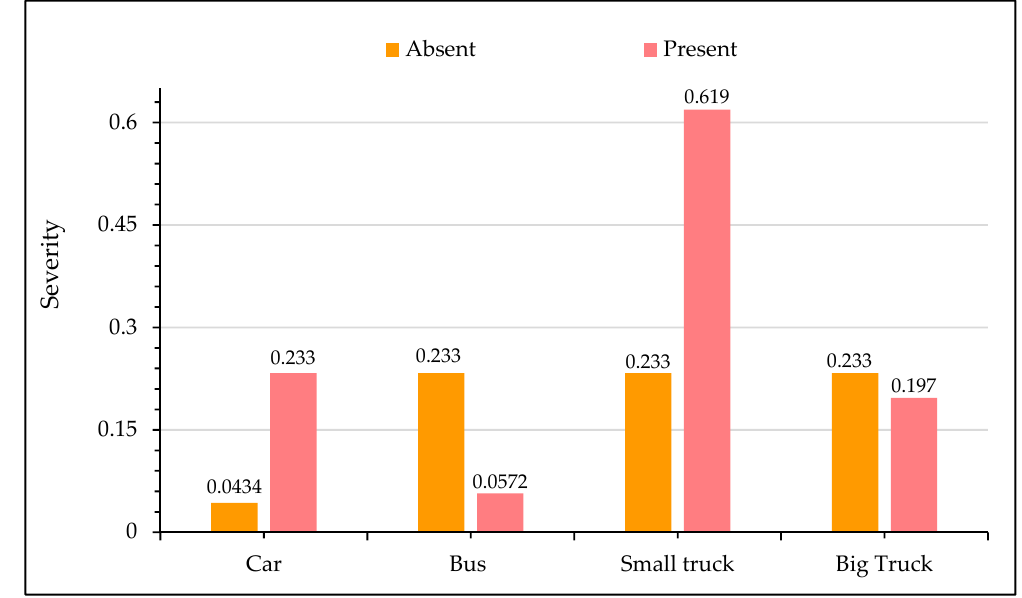
Figure 6. Effect of vehicle characteristics in crash severity. Figure 6. E ff ect of vehicle characteristics in crash severity. Int. J. Environ. Res. Public Health 2020 , 17 , x